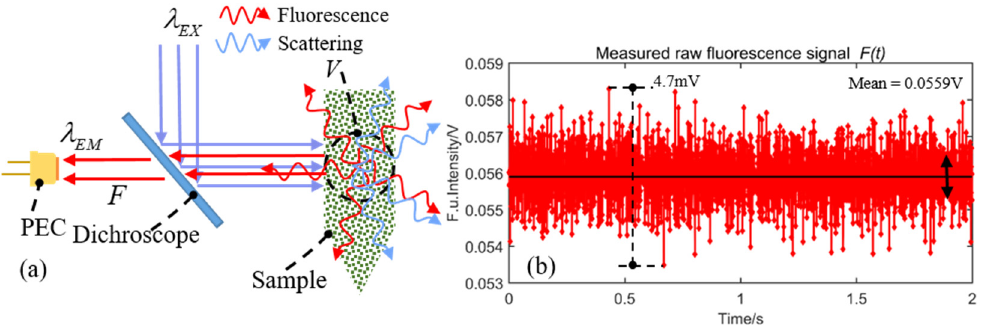
Figure 1. ( a ) Schematic view of fluorescence excitation. PEC: Photo-Electric Converter. ( b ) Raw fluorescence signal F ( t ) received by the PEC at 0.4 µ